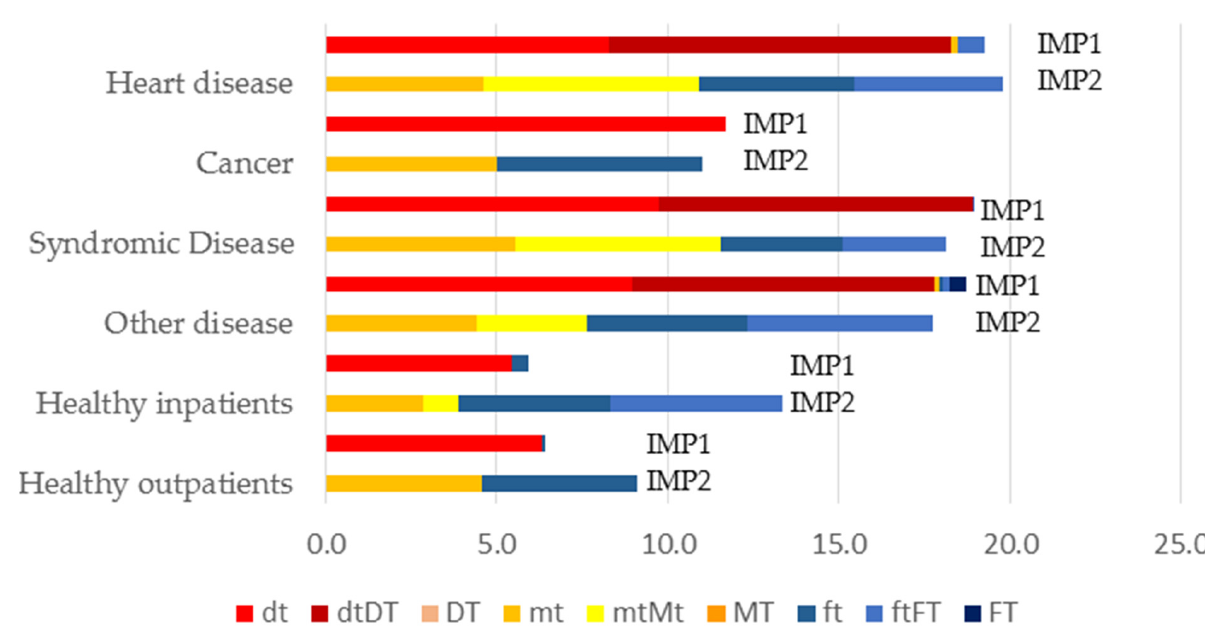
Figure 3. dmf-t/DMF-T index of pre-school children at first impulse (IMP1-pre-operative assessment) and second impulse (IMP2-dental treatment under GA): decayed (dt), missing (mt), and filled (ft) teeth for sole primary dentitions; decayed (dtDT), missing (mtMT), and filled teeth (ftFT) for mixed